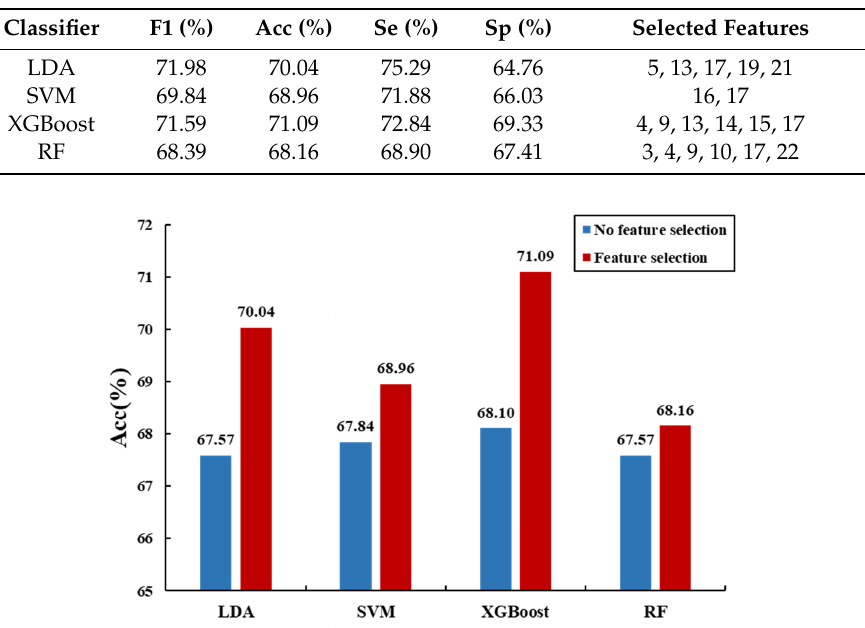
ff erent classifiers without or with feature Figure 5. Comparison of classification accuracy of different classifiers without or with feature selection. Figure 5. Comparison of classification accuracy of di